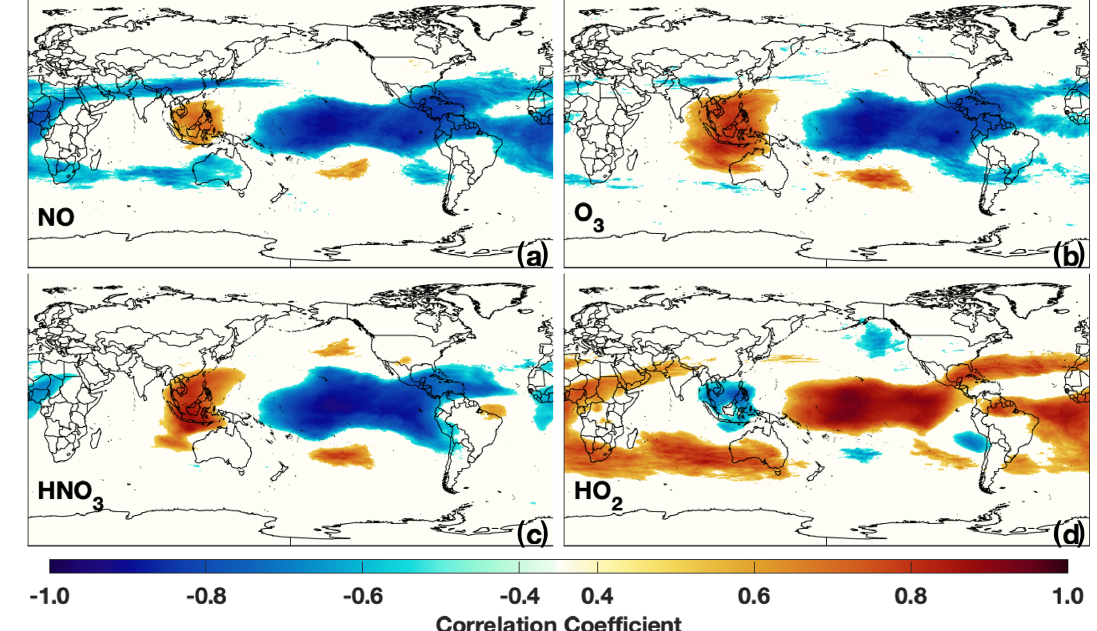
Figure 16. Correlation of the indicated species with the MEI for the UFT level for